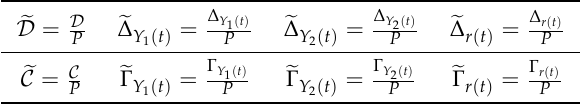
Table 3. Fisher-Weil Duration and Convexity, Delta and Gamma.